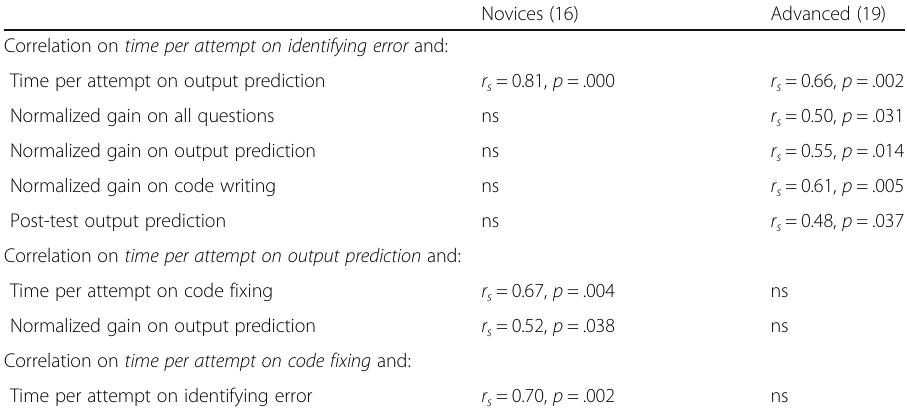
Table 7 Spearman ’ s correlations between time per attempt and normalized gains ( ns denotes not significant)